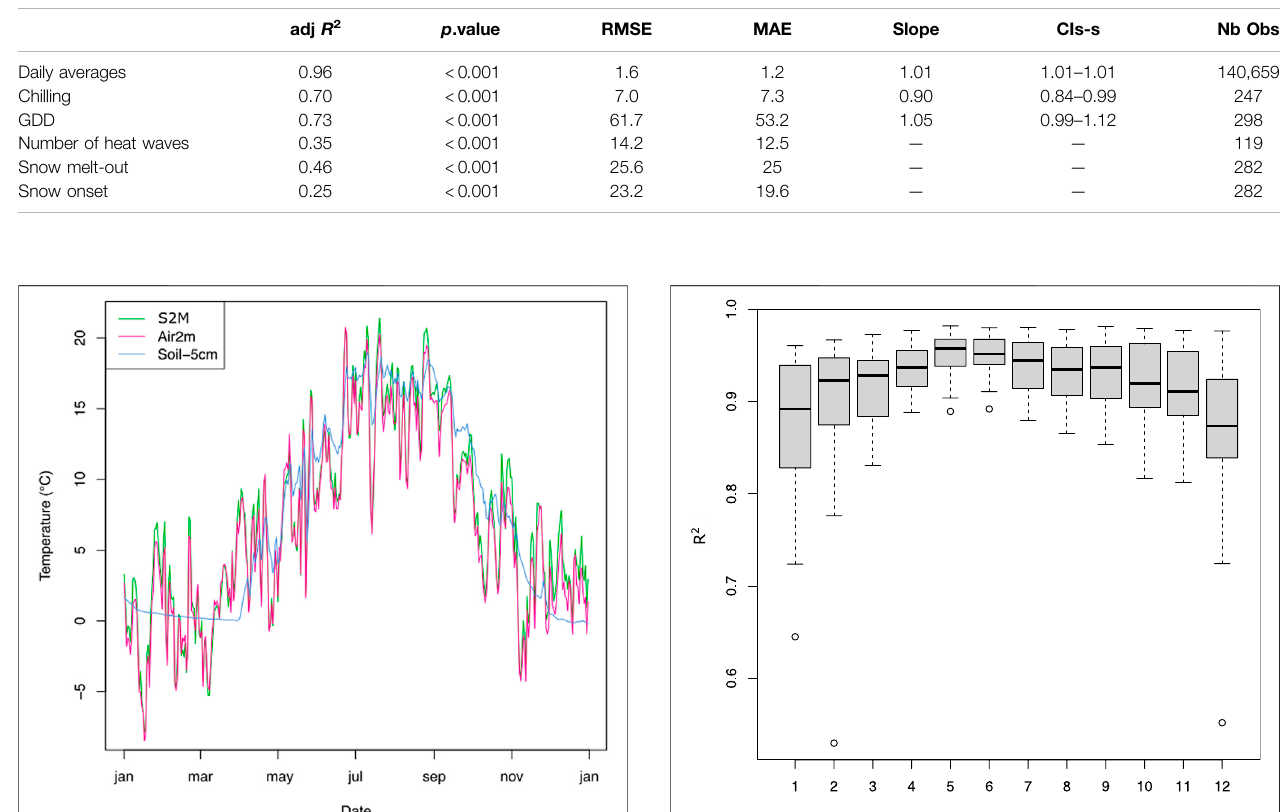
TABLE 1 | Results from linear regressions between indices calculated from S2M and stations. adj R 2 = adjusted R 2 , RMSE = Root mean squared error, MAE = Mean Absolute Error , Slope = best- fi t common regression slope calculated from MA, CIs = 95% con fi dence intervals of the slopes, Nb Obs = Number of observations .